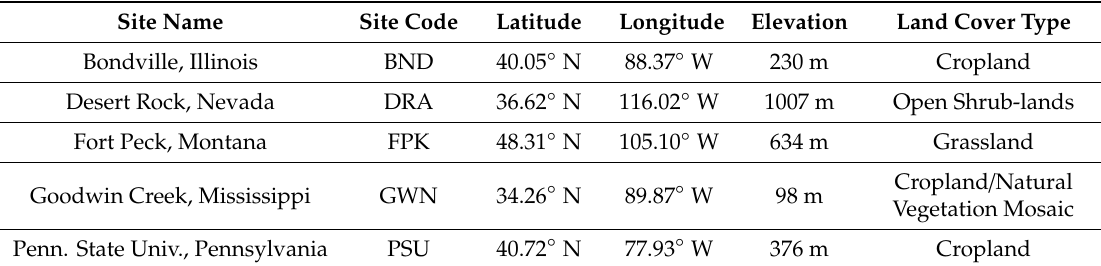
Table 1. Information about the Surface Radiation Budget Network (SURFRAD) experimental sites used in the